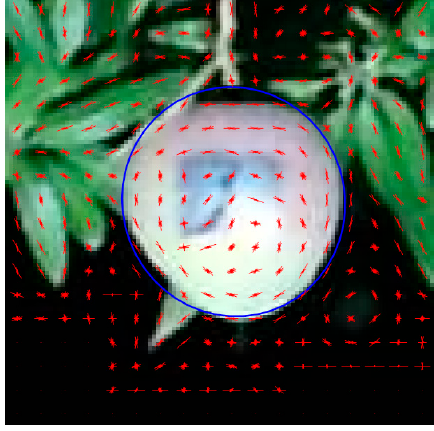
Figure 1. Histogram of Oriented Gradients (HOG) feature representation of mango fruit.